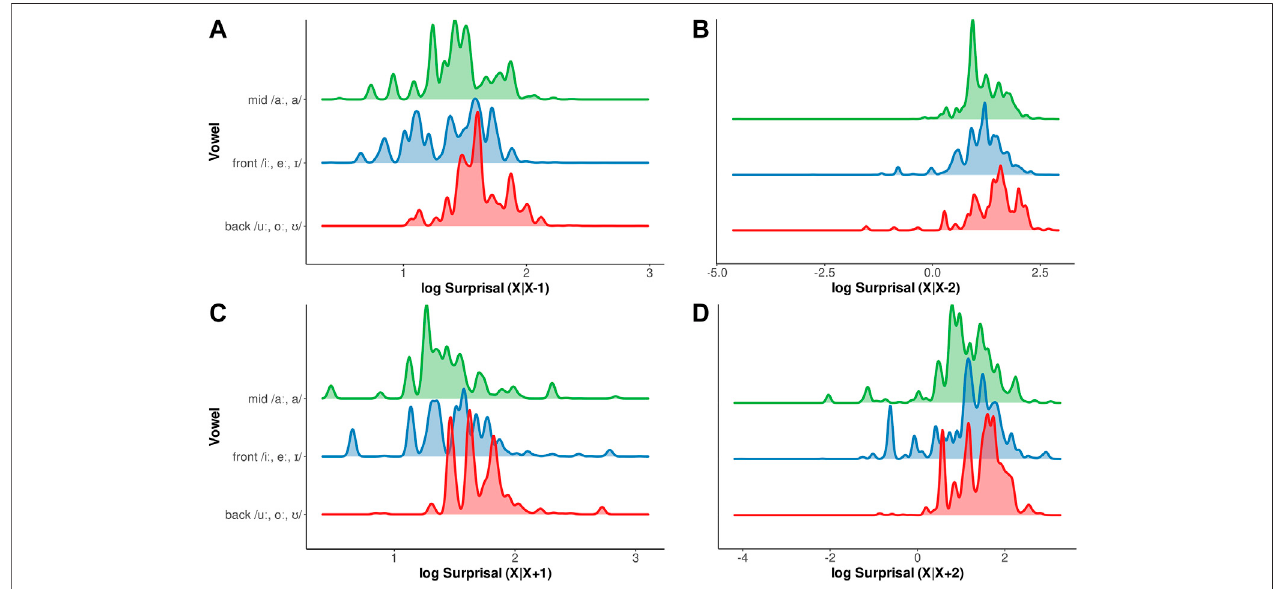
FIGURE 5 | Density plot of front, mid, and back vowels in different surprisal conditions of the preceding (A,B) or following (C,D) contexts.